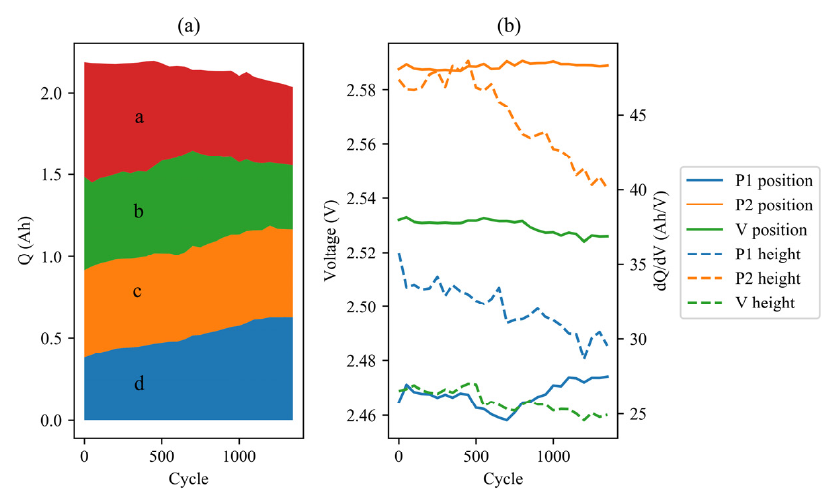
Figure 8. IC parameters (0.05 C) evolution of cell #7 during aging cycles: ( a ) area; ( b ) positions and heights of peaks.